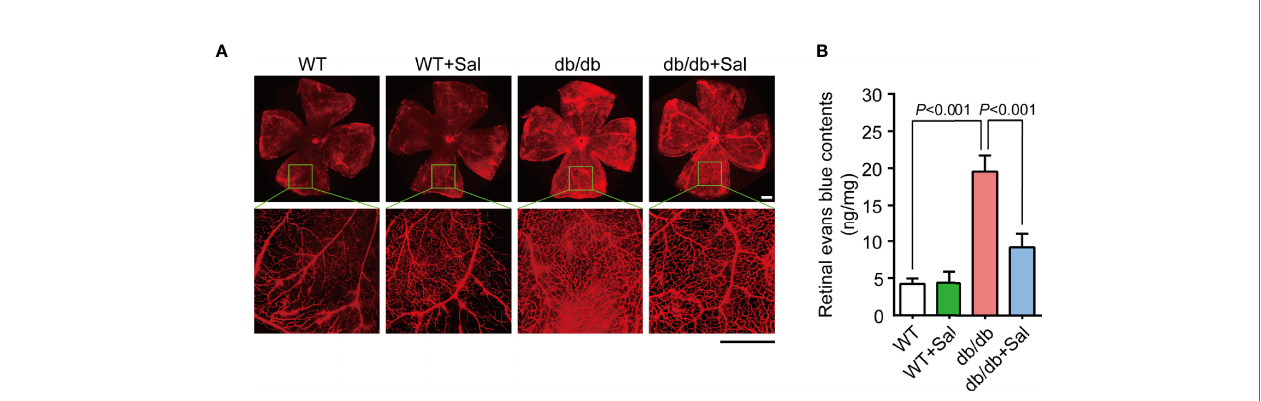
FIGURE 3 | Sal protected retinal vascular barrier function in db/db mice. (A) The representative photomicrographs of retinal vessels stained by evans blue in WT mice and db/db mice with or without Sal intervention. (B) Retinal normalized evans blue contents in WT and db/db mice after Sal intervention. Data are the mean ± SD. Scale bar = 500 m m.